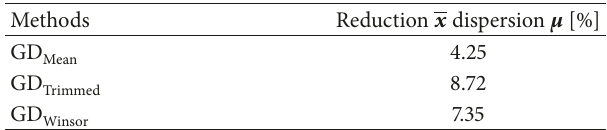
Table 38: Exponential with 20 points.